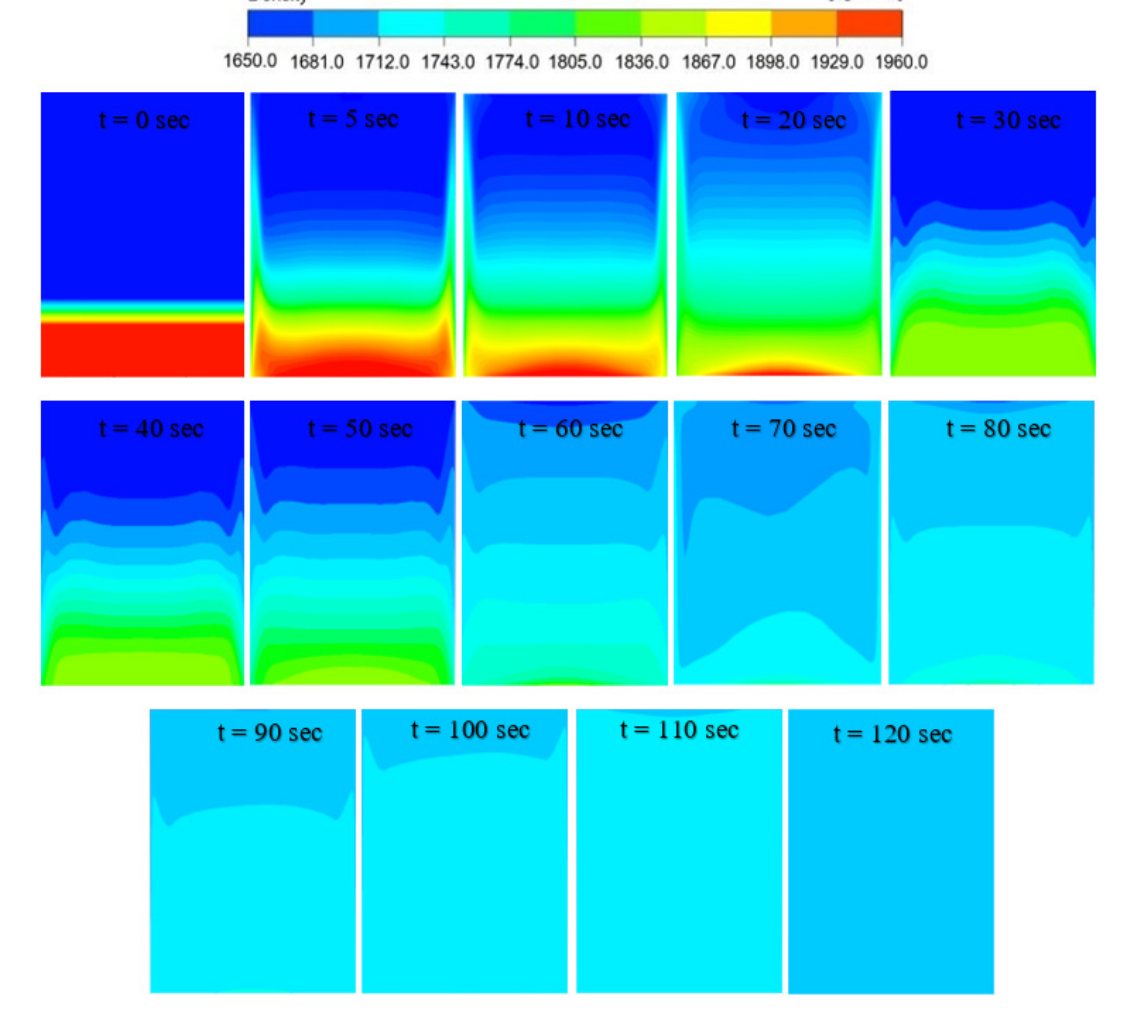
Figure 7. Plots of density contours from initial mass fraction distribution configuration (t = 0 s) to end time of the mixing process (t = 120 s).